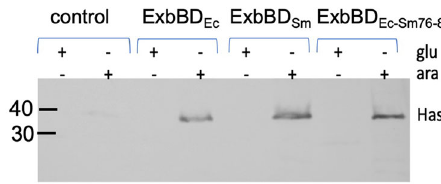
Fig. 8 ExbBD co-expression is necessary for HasB stabilization. Immunodetection of HasB in whole cells of E. coli JP313 Δ exbBD Δ tonB (pHasB33) also harboring pBAD24 (control), pBAD24ExbBD Ec , pBAD24ExbBD Sm or pBAD24ExbBD Ec-Sm76-88 , in the presence of either glucose (1 mg/ml) or arabinose (40 µ g/ml), indicated by the + signs. The equivalent of 0.2OD 600nm was loaded in each